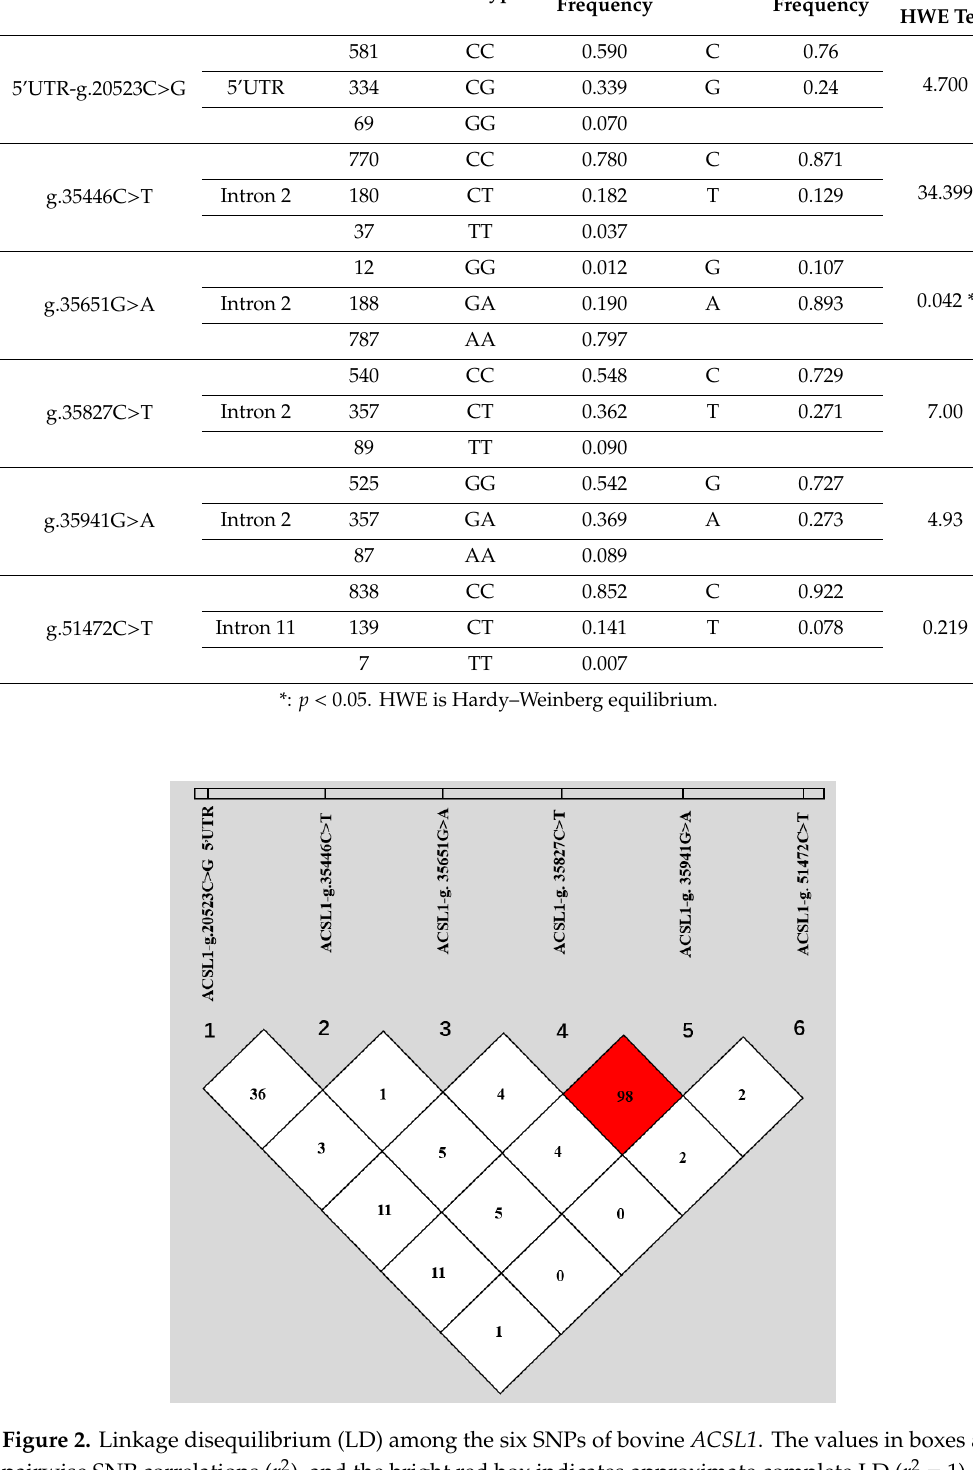
Figure 2. Linkage disequilibrium (LD) among the six SNPs of bovine ACSL1 . The values in boxes are pairwise SNP correlations ( r 2 ), and the bright red box indicates approximate complete LD ( r 2 = 1). Table 2. Genotypic and allelic frequency, and values of chi-square test significance for SNPs of ACSL1 genes in Chinese Holstein cows.